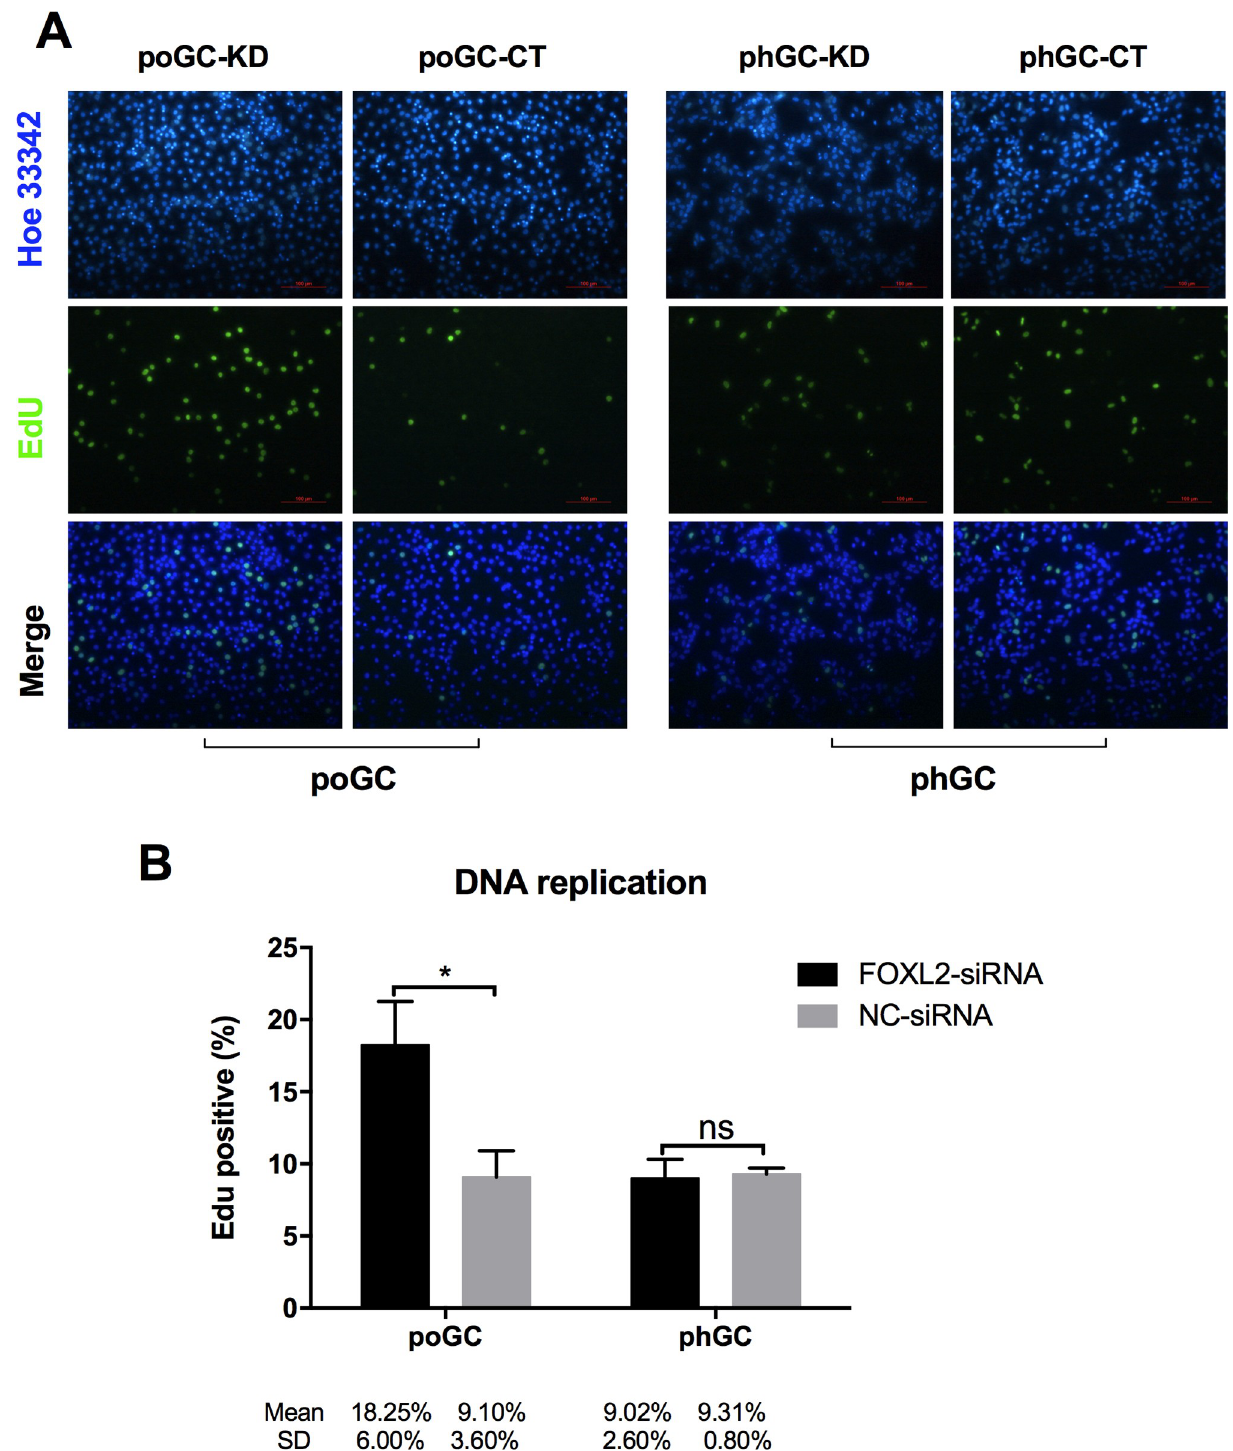
Fig 7. The effect of knocking down FOXL2 on DNA replication in the chicken granulosa cells. (A) Representative images of Hoechst 33342-stained cells (top, cell nuclei), EdU-stained cells (middle, DNA replication) and the merged images (bottom) of the four groups (poGC-KD, poGC-CT, phGC-KD and phGC-CT). Primary phGC and poGC were transfected with FOXL2-siRNA or NC-siRNA, and fresh EdU-containing medium replaced the original medium 6 h post-transfection. Then, the cells were cultured for an additional 24 h. (B) Summary of EdU add-in cells as percentages of the granulosa cells. Data are presented as the mean ± SD (n = 4) ( � indicates P < 0.05; ns indicates not significant).